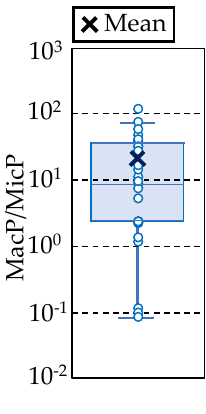
Figure 7. Box plots for the mass concentrations of MicP and MacP ( a ) and the value of MacP/MicP mass concentrations at each measurement site ( b ). These figures were based on the measurement data of Lebreton et al. [41]. The solid line represents the mean values; the tops and bottoms of the boxes denote the 75% and 25% quartiles, respectively, and the top and bottom of the error bars show the maximum and minimum values, excluding outliers. Crosses denote the mean data.